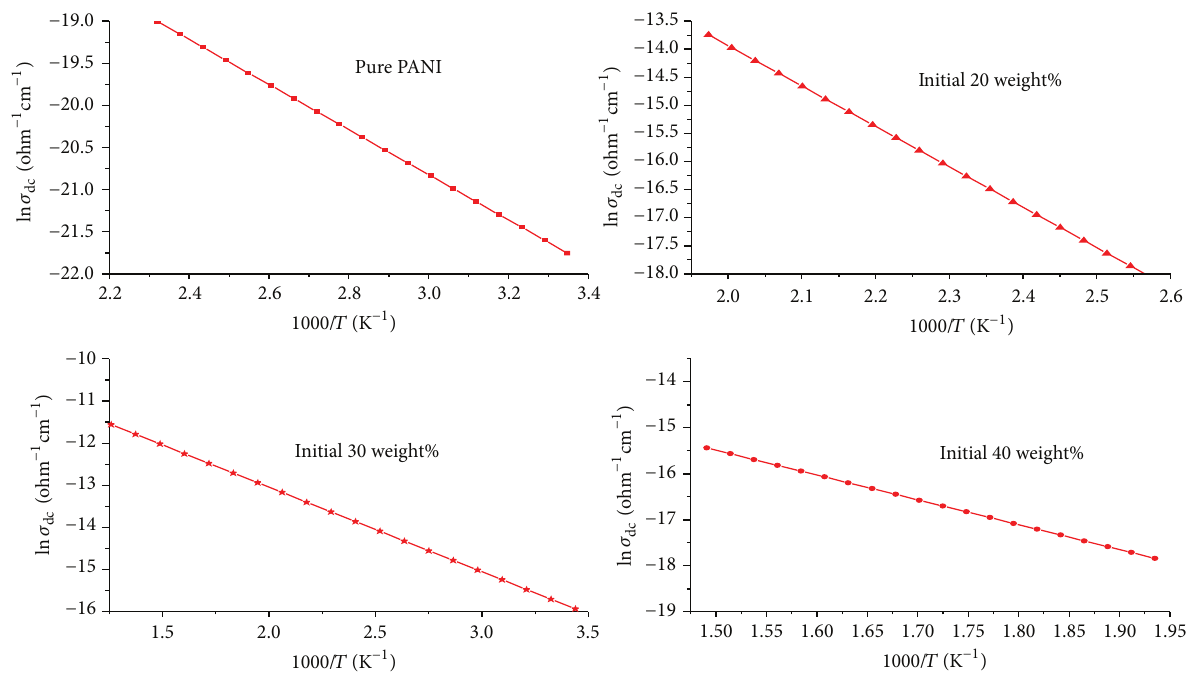
Figure 1: Temperature dependence of DC conductivity in the temperature range (300–550 K) for pure PANI and PANI/V 2 O 5 composites (different weight %). Table 1: Electrical and dielectric parameters of pure PANI and PANI/V